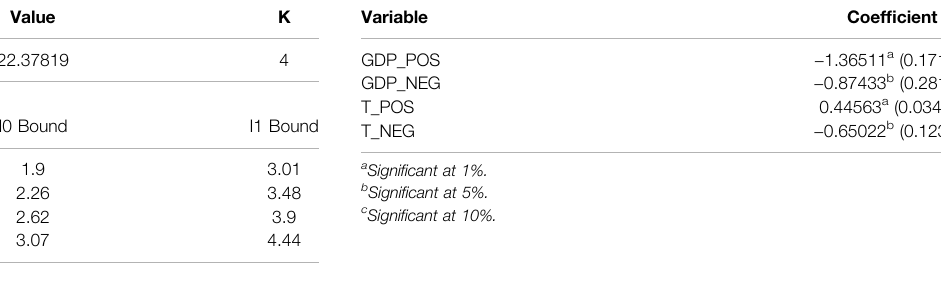
TABLE 5 | Pairwise Granger causality